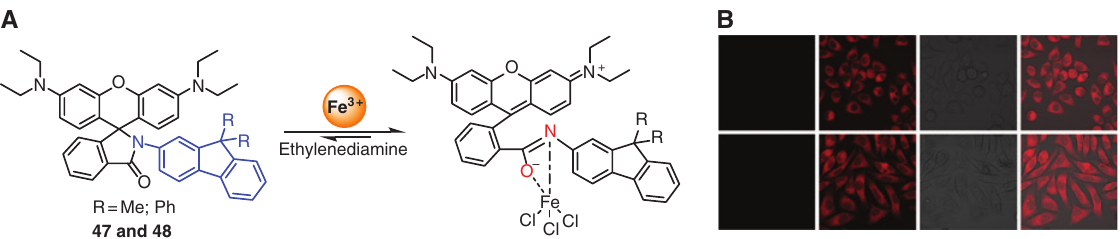
Figure 31: (A) Recognition mechanism of probes 47 and 48 with Fe 3 + and (B) intracellular fluorescent imaging of probes 47 and 48 with Fe 3 + in living L929 cells. Reprinted from Ma et al. (2015).